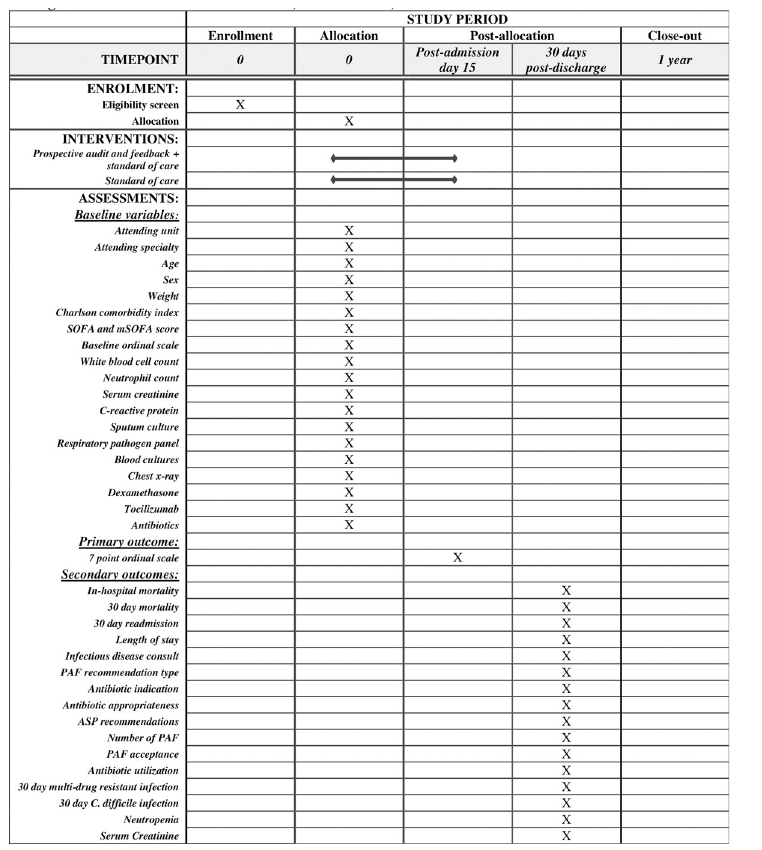
Fig 1. SPIRIT schedule of enrollment, interventions, and